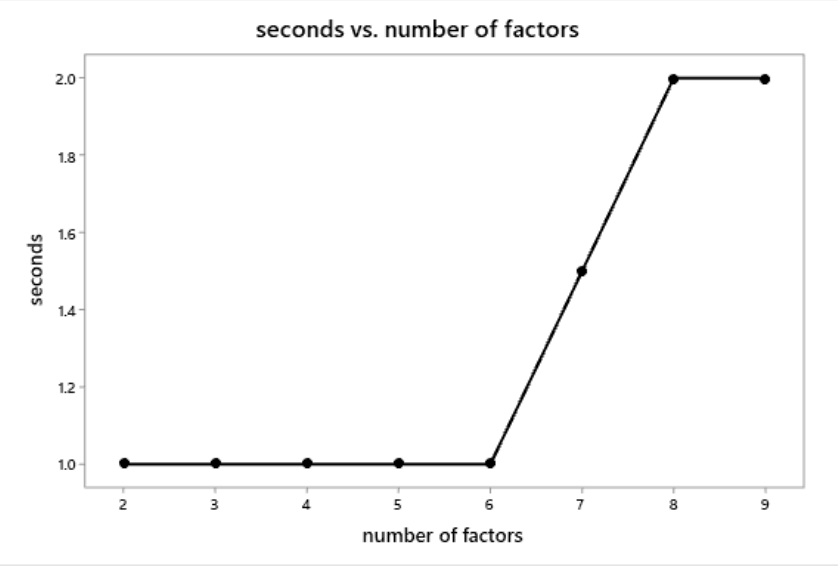
Figure 20. MATLAB Code computational